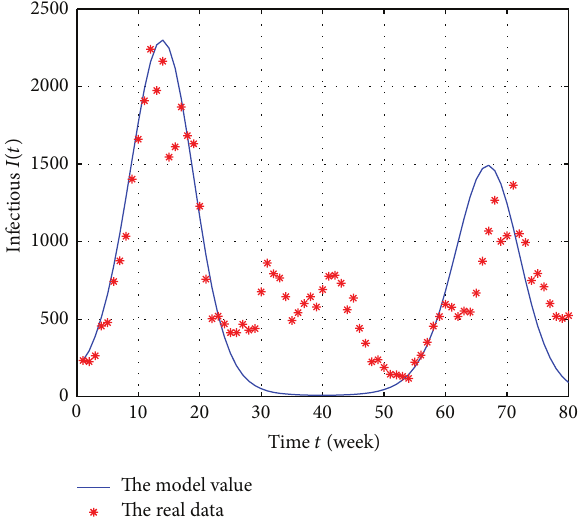
Figure 4: The solid curve represents the simulation results and the stars are the weekly data from 2012 to 2013 reported by the Wenzhou